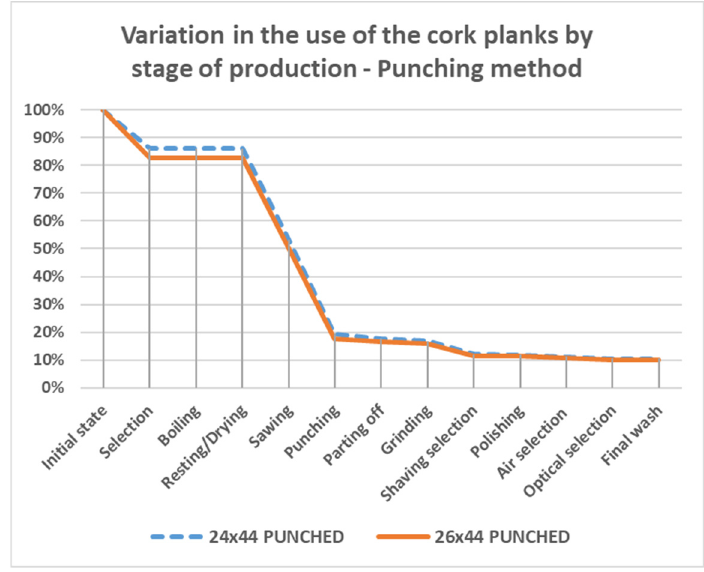
Figure 4. Variation in cork plank usage by production stage—punching method.